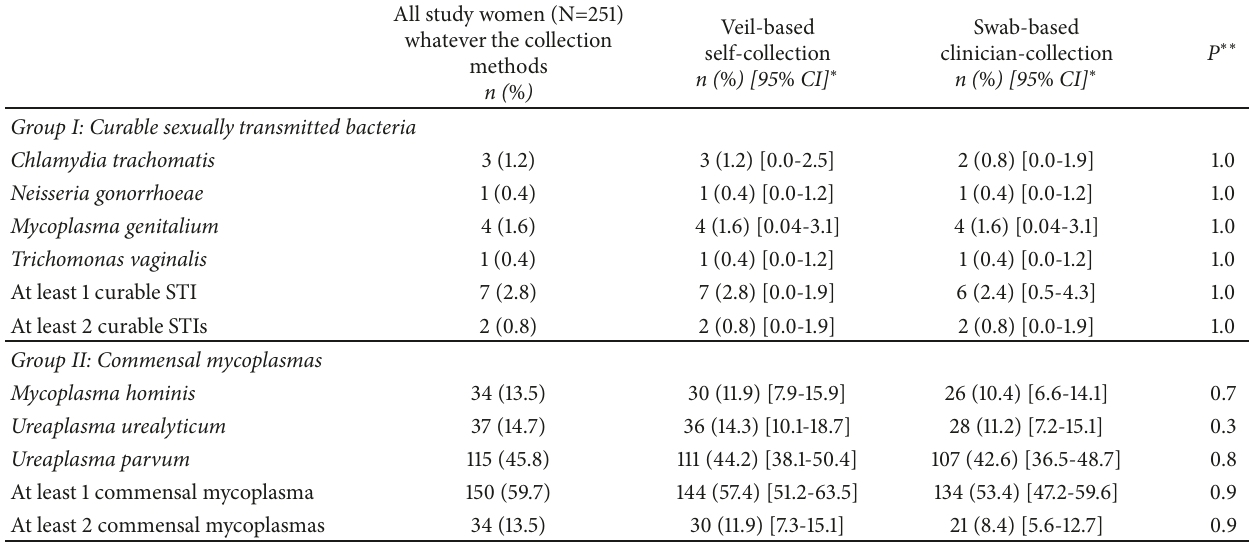
Table 2: Prevalences of common curable sexually transmitted infections (group I) and commensal mycoplasmas (apart from M. genitalium ) (group II) in the genital tract of 251 adult women living N’Djamena, Chad, and recruited from the